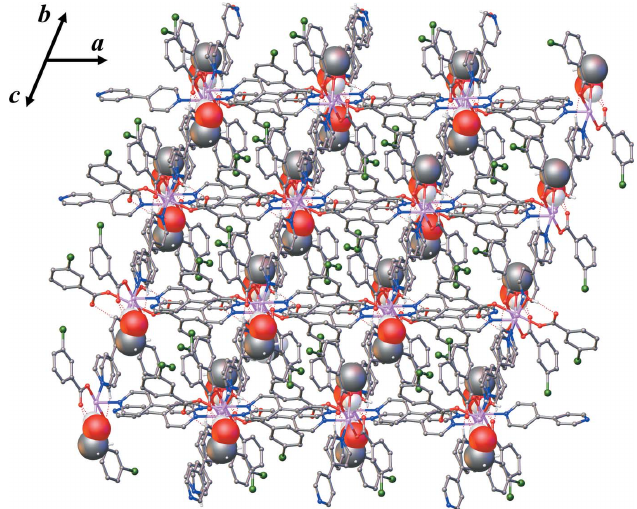
Figure 4 Packing diagram of the title compound viewed along the [011] direction . C-bound hydrogen atoms are omitted for clarity. Methanol solvate molecules are indicated by larger